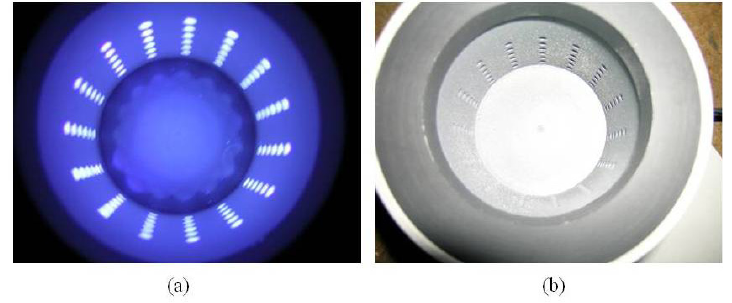
Figure A2. Top view of 365 nm LED rector: ( a ) lights on ( b ) lights off, Adapted from reference